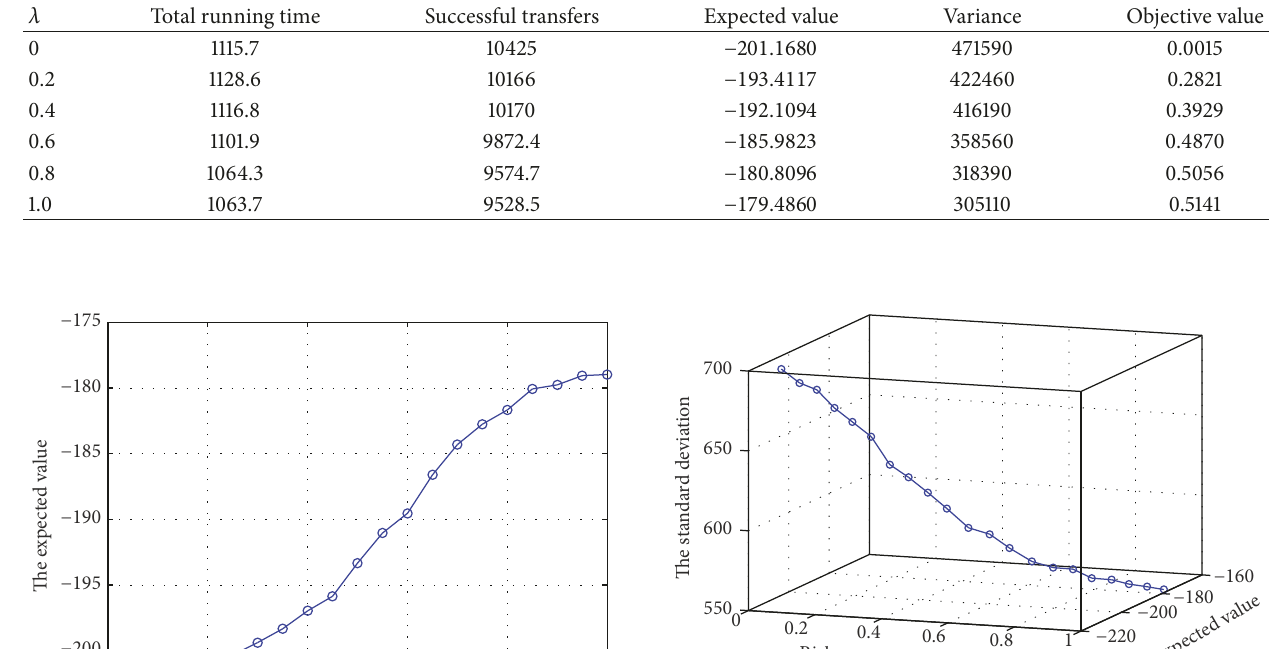
Table 3: Comparison of solution results.